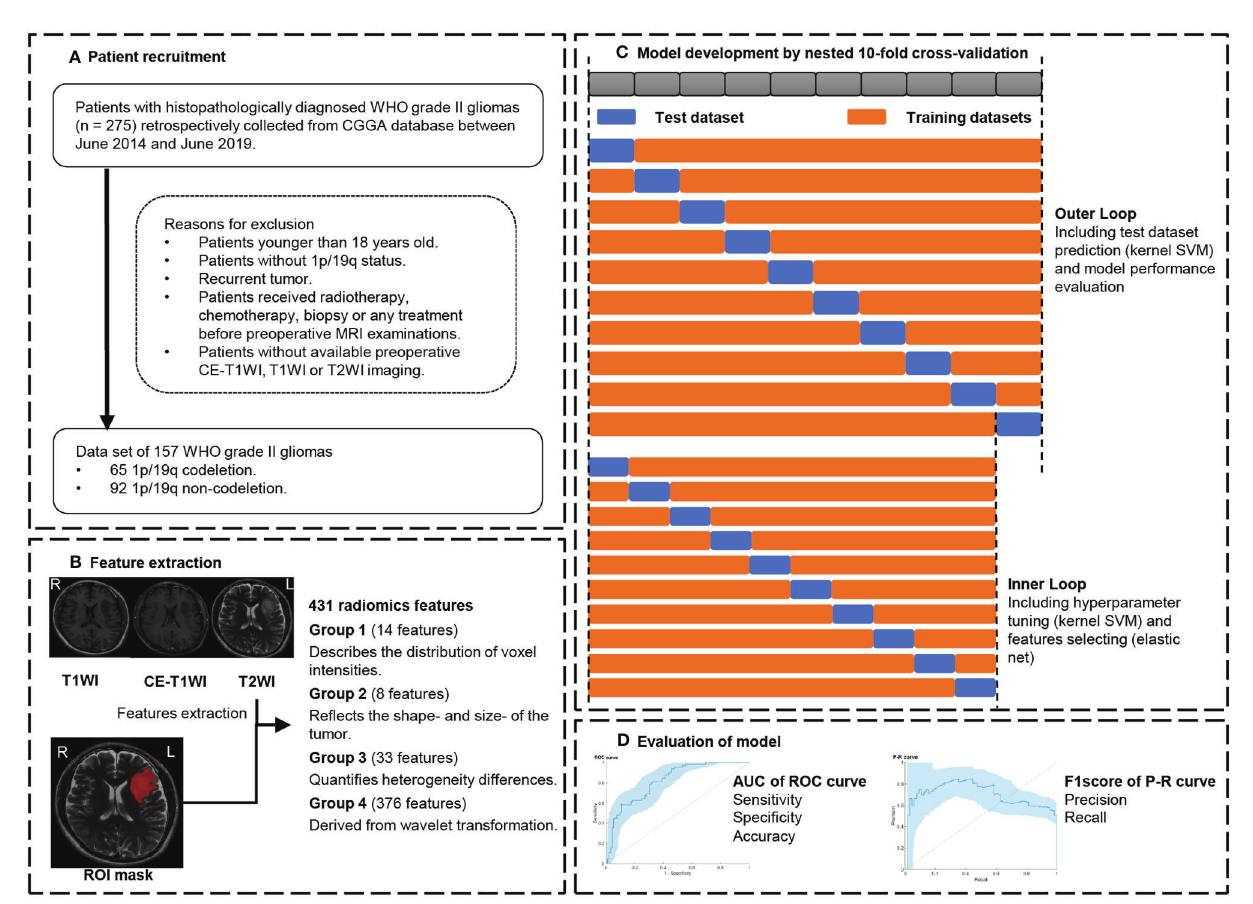
FIGURE 1 | Work fl ow. (A) Patient recruitment strategy. (B) 431 features were extracted from region of interest (ROI) on each magnetic resonance imaging (MRI) sequence. (C) To compute a 10 × 10-fold nested cross-validation scheme, data were split into 9 training sets and a test set in the outer loop. The inner loop included hyperparameter tuning and features selection in the training datasets. After feature selection, the model with optimal parameters was used for prediction in the test set. This procedure developed 10 different models with speci fi c sets of features and hyperparameters. (D) receiver operating characteristic (ROC) analysis and precision and recall (P-R) analysis were used for model performance evaluation. CGGA, Chinese Glioma Genome Atlas database; CE-T1WI, contrast-enhanced T1-weighted imaging; T2WI, T2-weighted imaging; AUC, area under the